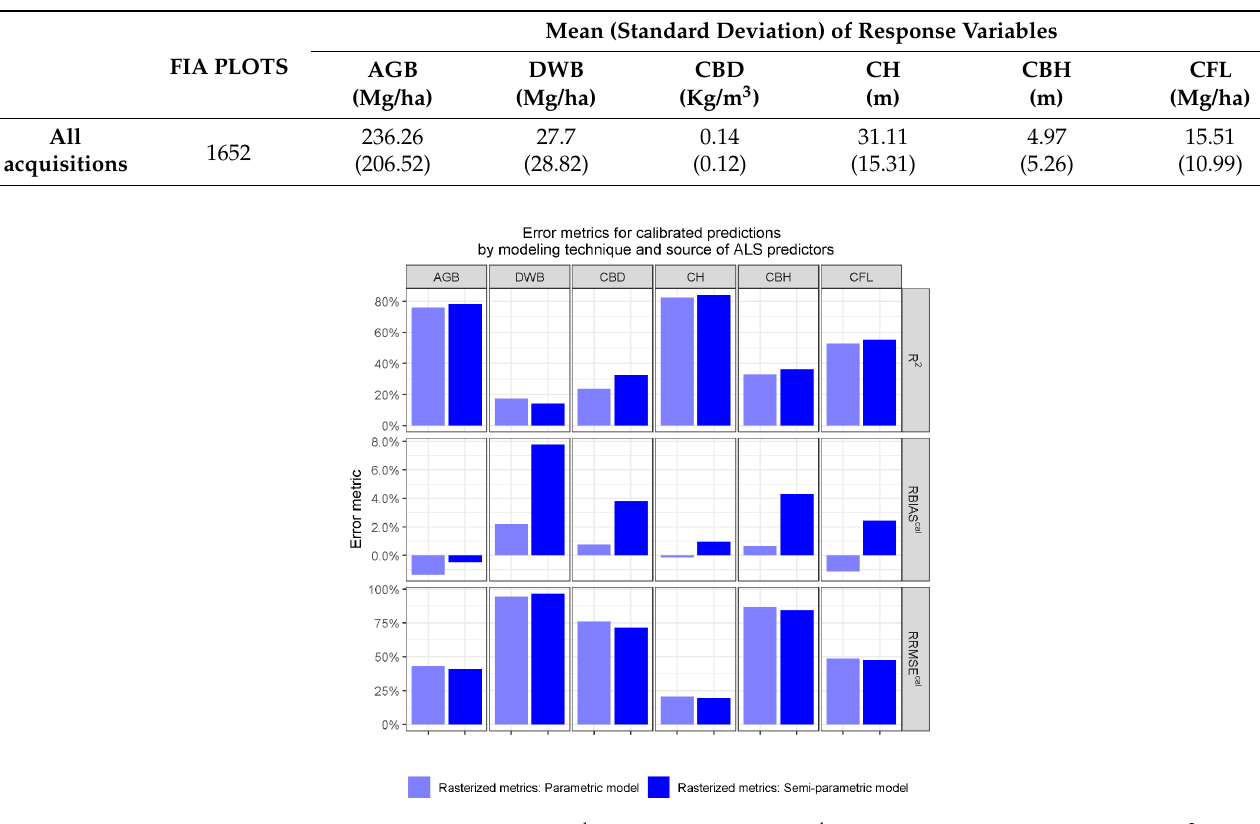
Figure A2. Relative root mean squared error ( RRMSE cal ), relative bias ( RBIAS cal ), and coefficient of determination ( R 2 ) for parametric and semiparametric models using rasterized predictors in the extended dataset of 20 ALS acquisitions. Model response variables are: aboveground biomass (AGB), downed woody biomass (DWB), canopy bulk density (CBD), canopy height (CH), canopy base height (CBH), and canopy fuel loading (CFL). Table A3. Global differences between parametric and semiparametric models in the extended dataset of 20 ALS acquisi- tions. AGB, DWB, CBD, CH, CBH, and CFL respectively indicate aboveground biomass, downed woody biomass, canopy bulk density, canopy height, canopy base height, and canopy fuel load. Superscripts (cid:1868) and (cid:1871)(cid:1868) indicate error metrics for parametric and semiparametric models respectively and the superscript (cid:1865) denote changes in (cid:1844)(cid:1828)(cid:1835)(cid:1827)(cid:1845) and (cid:1844)(cid:1844)(cid:1839)(cid:1845)(cid:1831) due to using a different modeling technique.